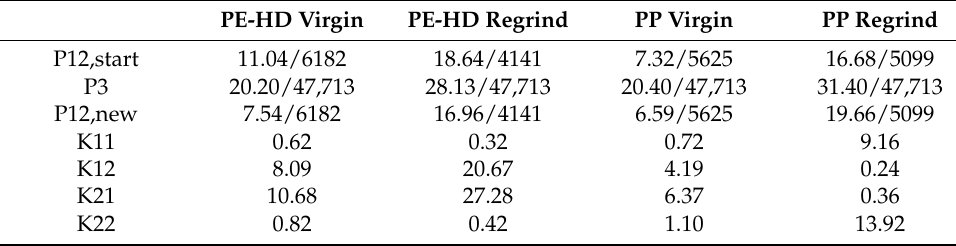
Table A1. Material parameters for the numerical simulation.